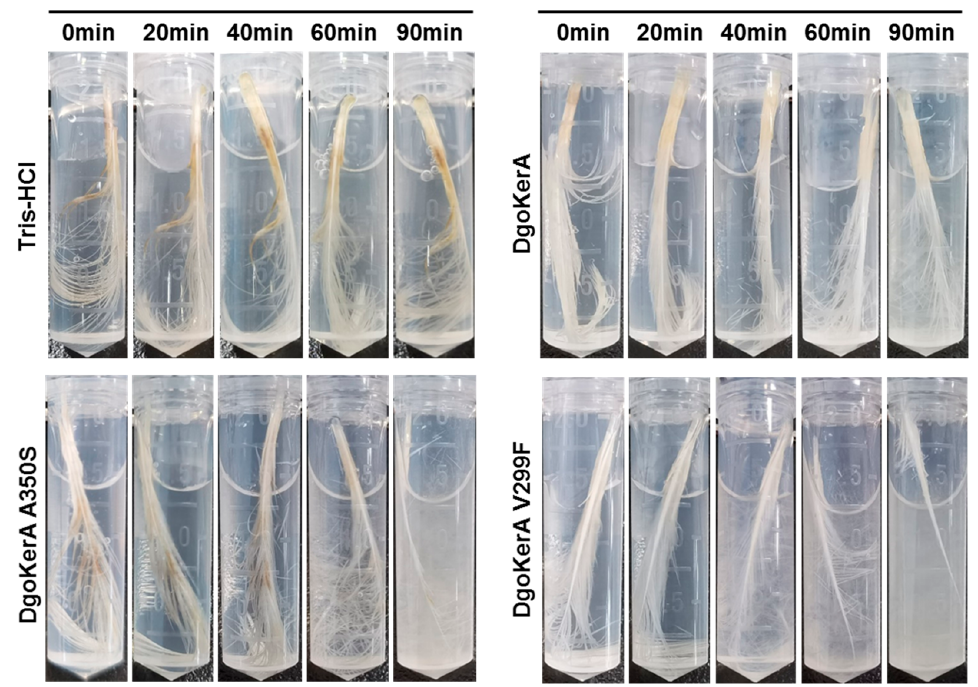
Figure 6. Comparison of intact feather degradation capacities of DgoKerA and mutants. Tris-HCl is a control without keratinase. The reaction systems were incubated at 60 °C with shaking.